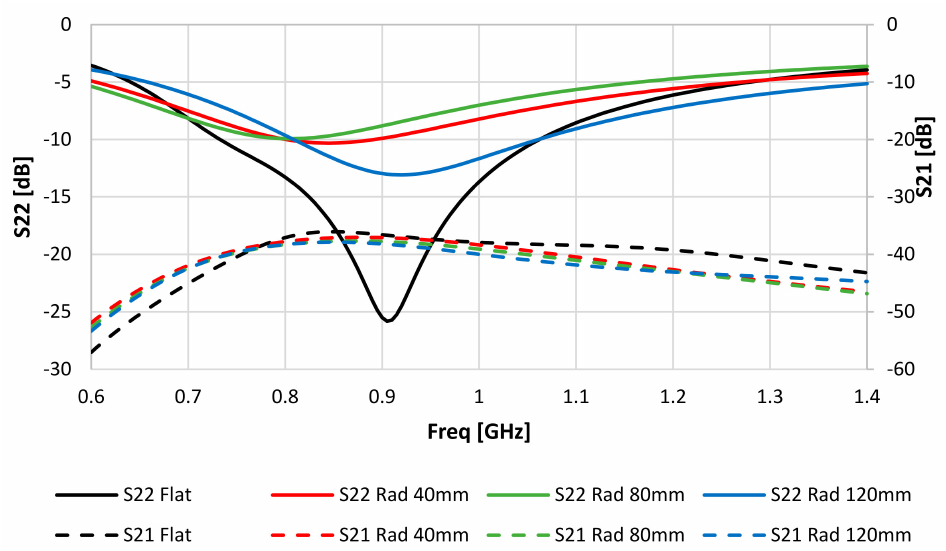
Figure 5. Simulated S 21 and S 22 for the IM under three bending cases (Kapton thickness of 0.8 mm).